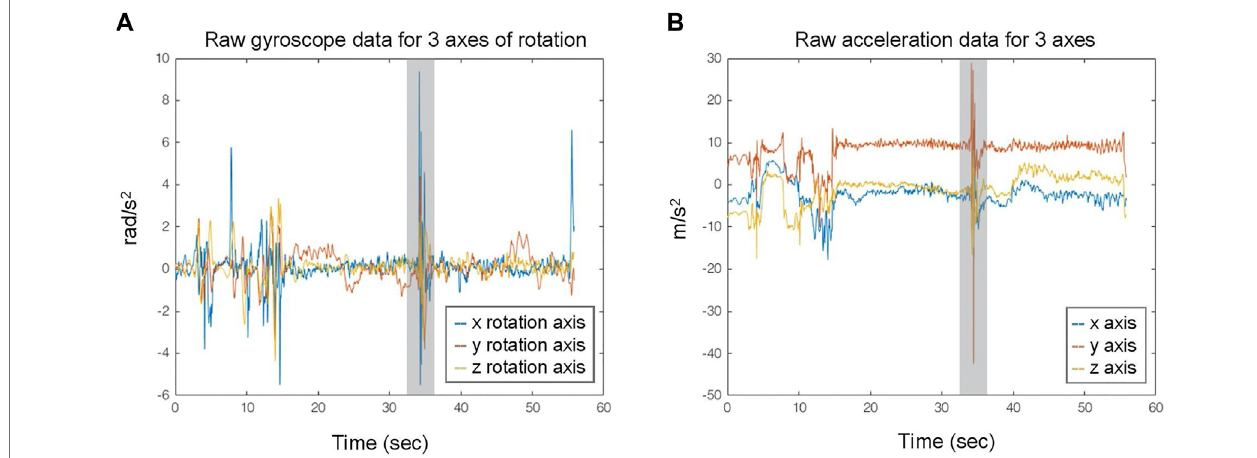
FIGURE 1 | Exemplary data streams from triaxial gyroscope (A) and accelerometer (B) IMU recordings. The gray area indicates the FoG events.